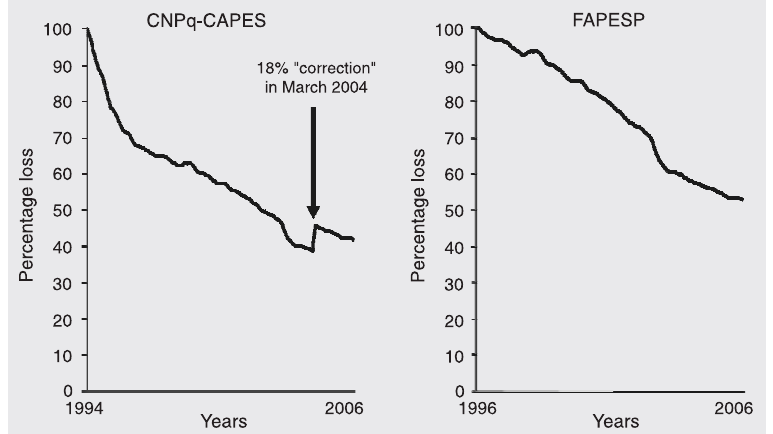
Figure 10. Percentage loss of purchasing power of CNPq and CAPES (left panel), and FAPESP (right panel) graduate scholarships between 1994 (CNPq and CAPES) or 1996 FAPESP (1996) and 2006 (calcu- lated using a National Consumer Price Index, the “Índice Nacional de Preços ao Consumidor” (INPC) calculated by the Instituto Brasileiro de Geografia e Estatística, IBGE, an official agency, and considering the scholarship values for 1994 (CNPq and CAPES) or 1996 FAPESP as